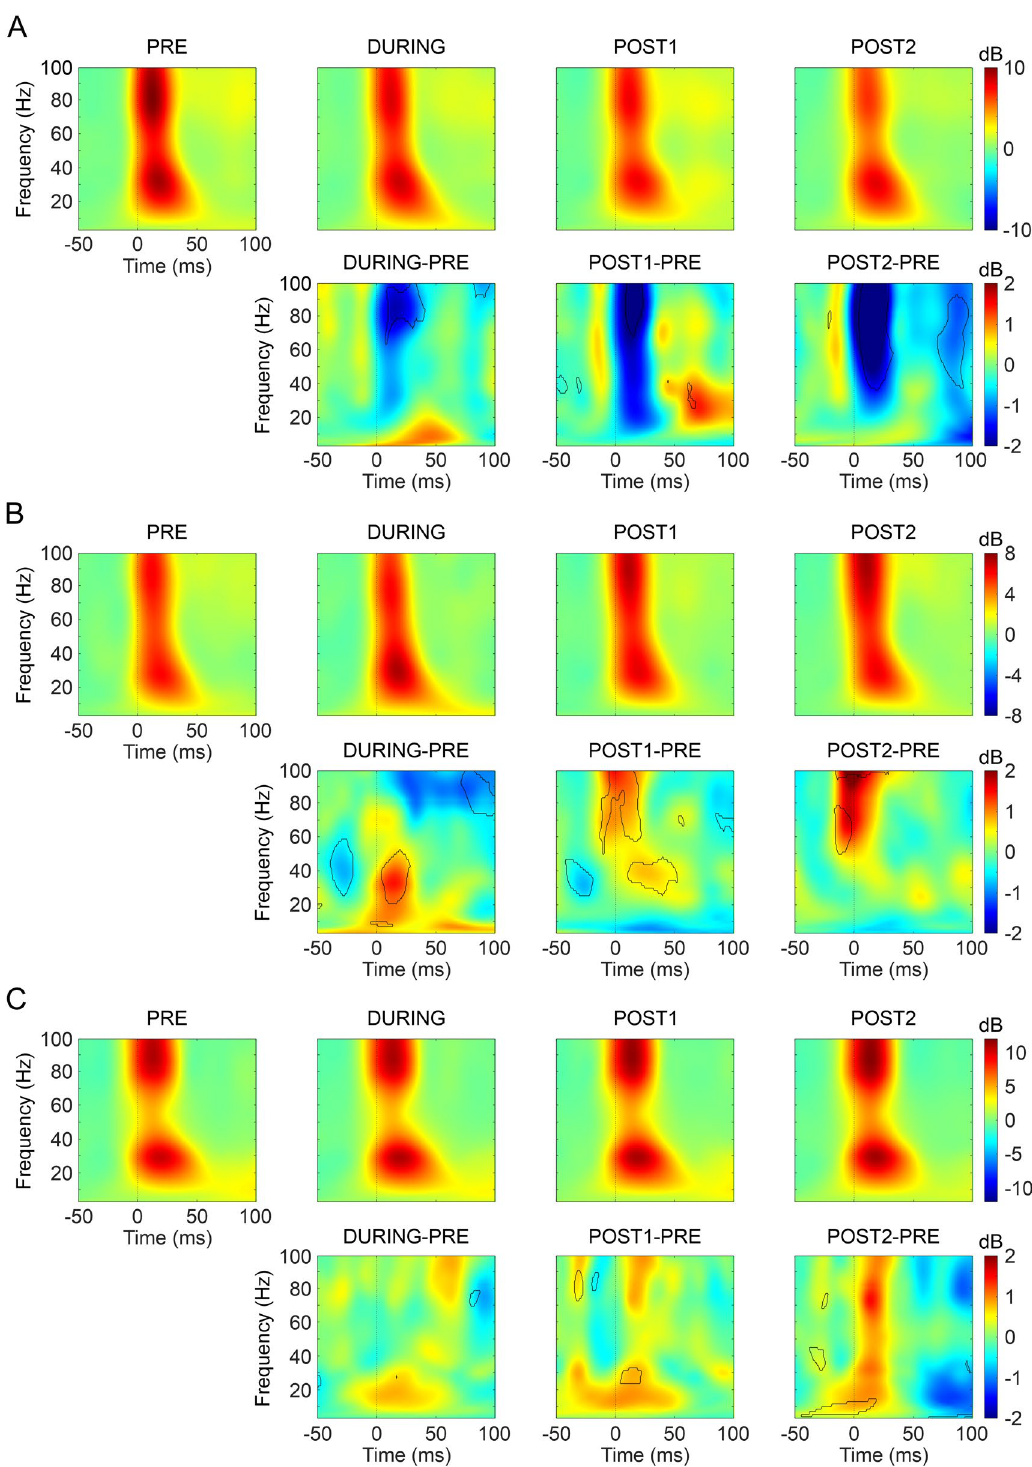
Figure 6. ERSP analysis of the induced activity. ( A–C ) (Upper row) ERSP obtained for the 20 min before stimulation (PRE, first column), during tDCS (DURING, second column), the first 20 min after tDCS cessation (POST1, third column) and the next 20 min (POST2, fourth column) for cathodal ( A ), anodal ( B ) or sham ( C ) tDCS. (Lower row) Differences between the ERSP obtained in the 20 min before stimulation (PRE) and DURING (first column), POST1 (second column) or POST2 (third column) for cathodal ( A ), anodal ( B ) or sham ( C ) tDCS. Black outline represents statistical differences for that frequency and time range ( p < 0.05,